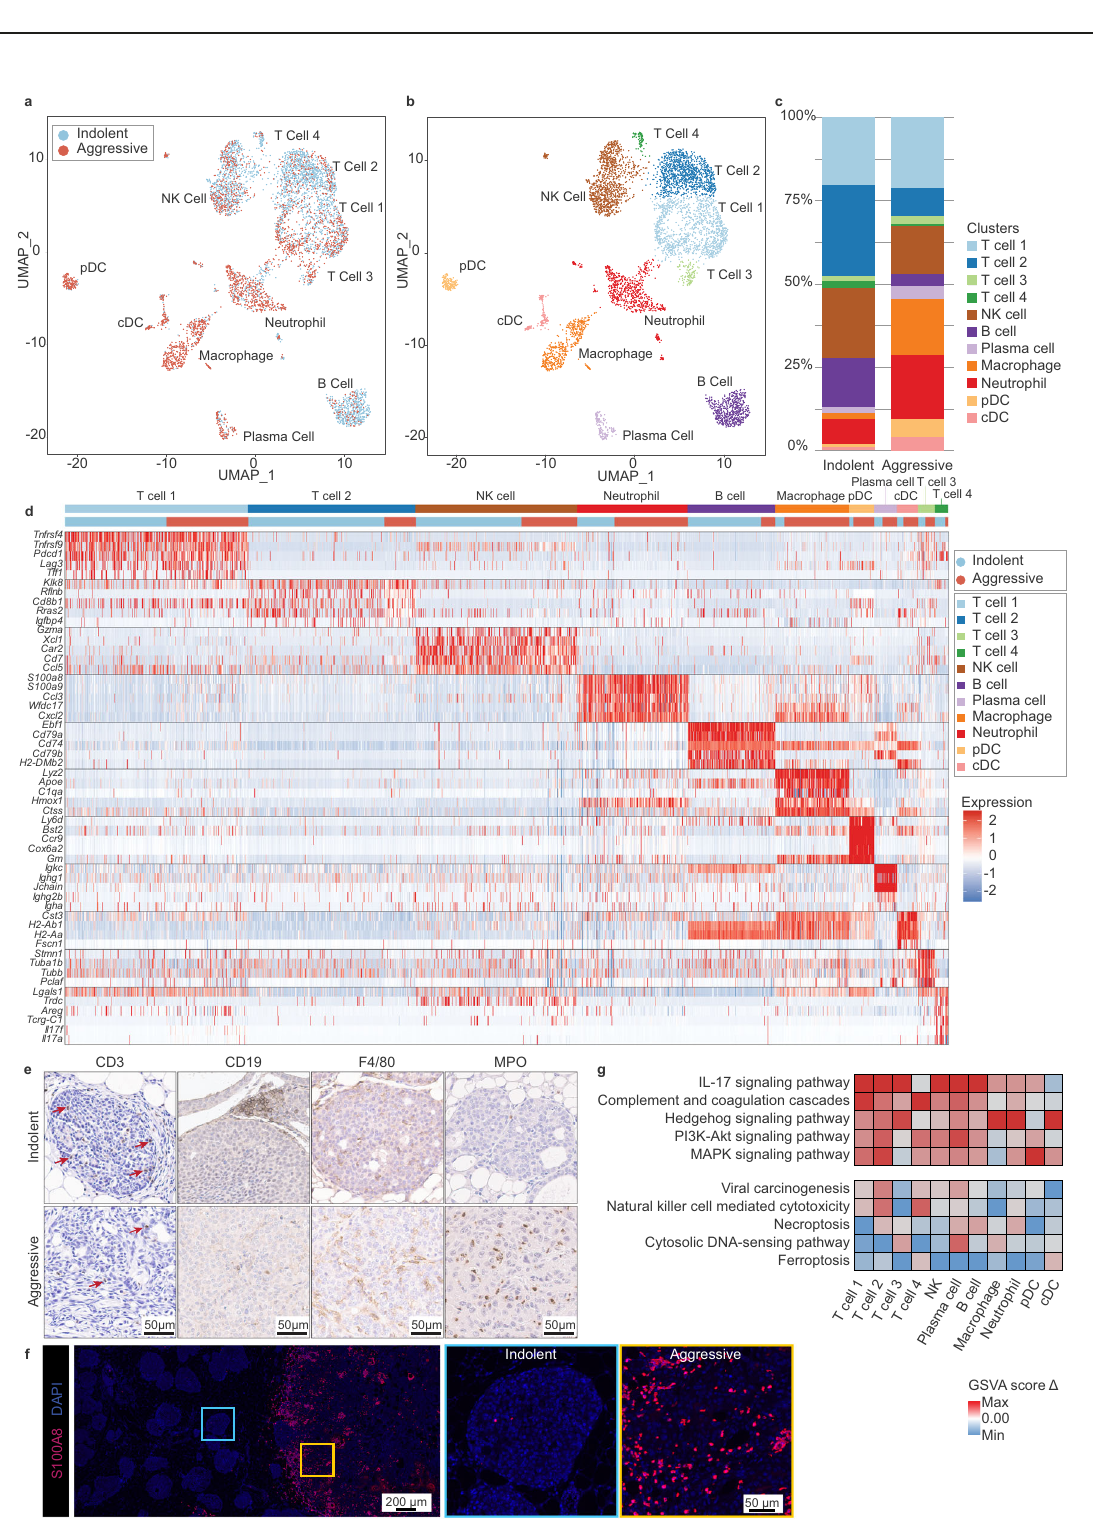
Fig. 5 Heterogeneous pathway enrichment across tumor subpopulations suggest distinct functional roles in the tumor niche. a , b Comparison of pathway enrichment across tumor subpopulations. Heatmap of enrichment scores of selected Hallmarks ( a ) and KEGG ( b ) pathways in tumor clusters following gene set variation analysis (GSVA). Positive score indicates relative enrichment vs. other populations identi fi ed by scRNA-seq and pathways within the same collection. Cells from indolent and aggressive lesions were analyzed together per cluster. c Comparison of pathway changes in indolent vs. aggressive lesions: clusters were analyzed by lesion type to calculate a change in Hallmark pathway enrichment score (GSVA delta, Δ ) in aggressive vs. indolent lesions. Positive score indicates increased score in aggressive lesions. Pathways were classi fi ed as concordantly (top two panels) or discordantly (bottom two panels) shifted in Luminal 1 and Basal populations of aggressive lesions compared to indolent lesions. Source data are provided as a Source Data fi le.